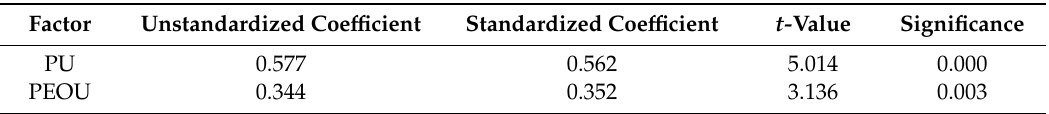
Table 3. Results of multiple regression analysis with regression coefficients and significance test for questionnaire of technology acceptance model.